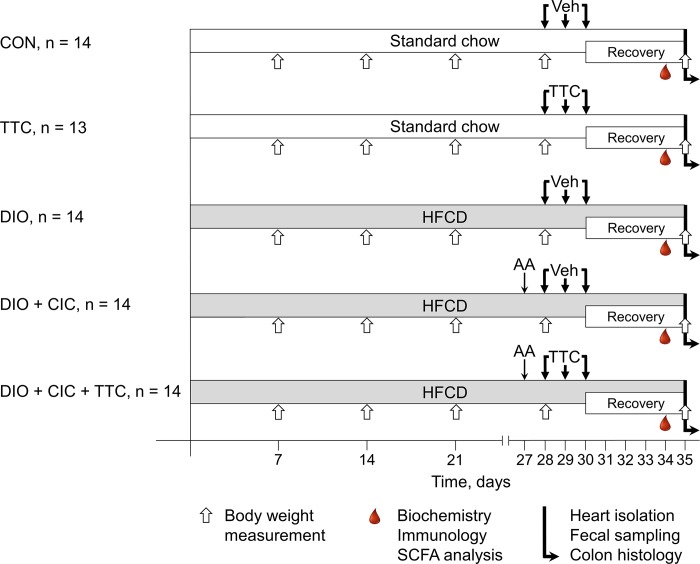
Experimental design.For details, see text. AA–acetic acid, HFCD–high-fat, high-carbohydrate diet, Veh–vehicle, TTC–tetracycline, SCFAs–short chain fatty acids.